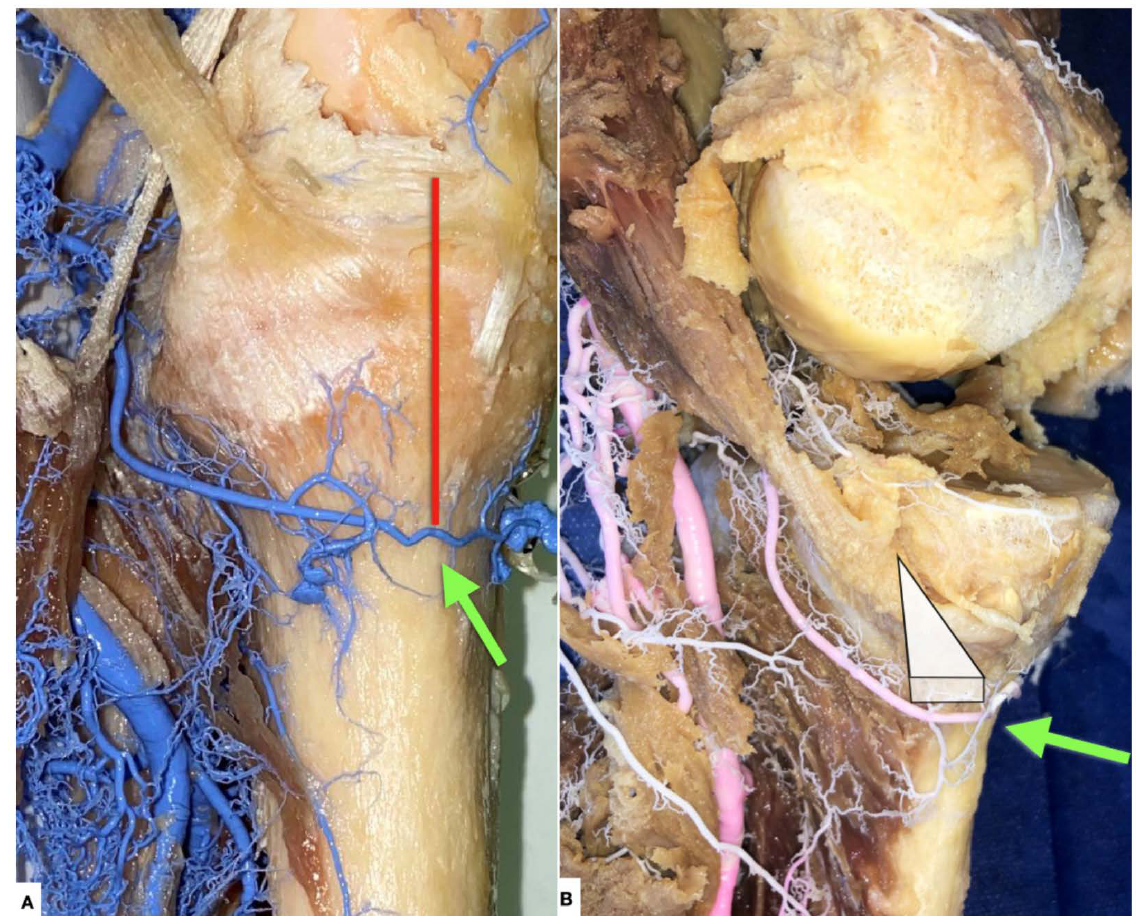
Figure 8. ( A ) Left knee, medial view. Green arrow: inferior medial geniculate artery (IMGA). Red line: distance of IMGA from joint line. Sinno et al. calculated the distance between IMGA and the joint line to be 30 ± 4.3 mm on the sagittal plane and 29.9 ± 4 mm on the coronal plane [9]. There was no statistically significant difference between these two distances. This translates that the IMGA travels below the medial tibial condyle in an almost parallel fashion consistently. Barner et al. calculated the distance between the IMGA and the joint line at the medial knee to be 33 mm ± 6.9 mm [3]. ( B ) Left knee, medial view. Green arrow: inferior medial geniculate artery (IMGA). Bissichia et al. found the IMGA to be at risk during opening-wedge proximal tibial osteotomy, with a median distance from the osteotomy site around 2.1 mm [4]. White triangular wedge-shaped drawing: represents orientation of medial open wedge high tibial